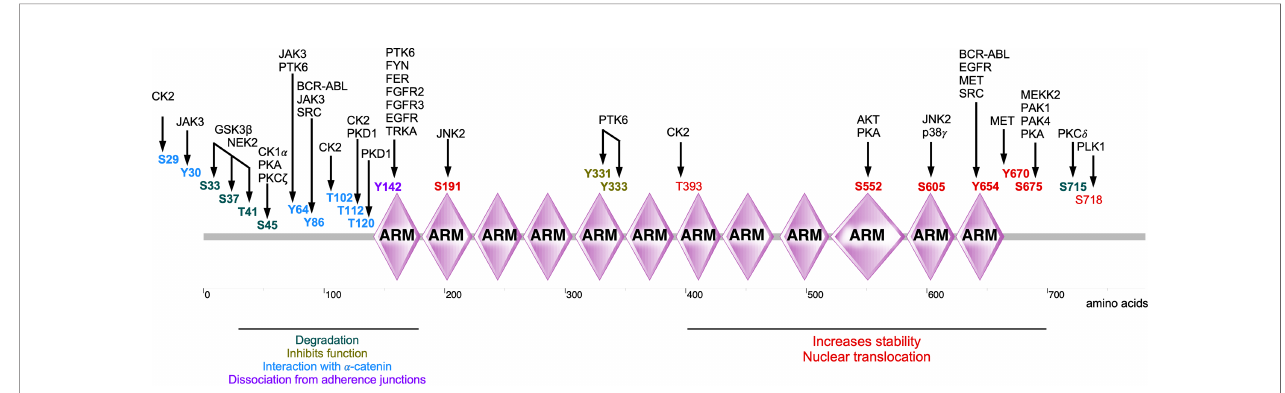
FIGURE 5 | Phosphorylations sites of b -catenin. Several kinases are involved in the phosphorylation of b -catenin, thereby regulating its stability, localization, and activity of b -catenin.